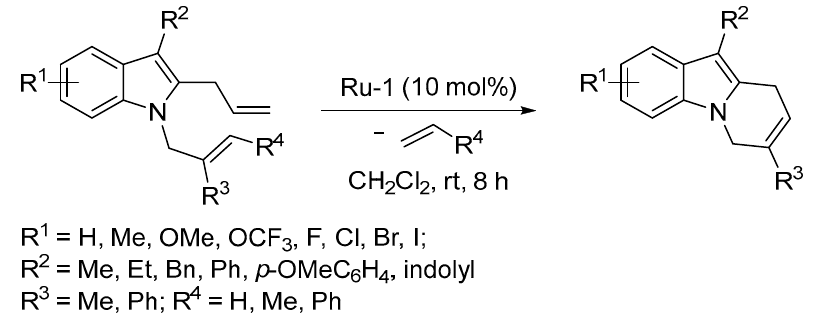
Scheme 26. RCM of